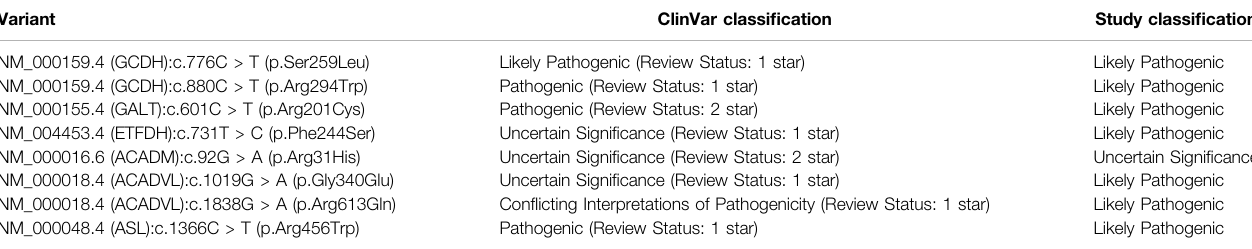
TABLE 4 | Classi fi cations of eight variants identi fi ed in time-stamp analysis. Eight variants classi fi ed in this study were submitted to ClinVar since the original search for submissions.Theclassi fi cations assignedtotheeightvariantsinClinVar,aswellasthereviewstatus,andinthisstudyareshown.Onestarandtwo-star reviewstatuses correspond to variants having criteria provided by a single submitter and criteria provided by multiple submitters without con fl icting interpretations, respectively.